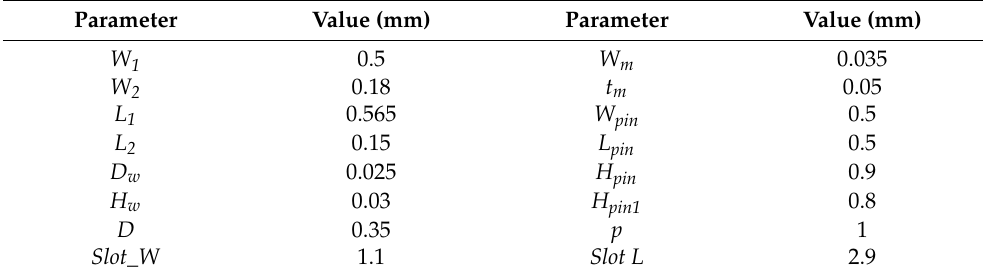
Figure 10. Effect of the bond wire length on the designed transition frequency response. Table 2. Optimum dimension parameters for the MMIC-to-waveguide transition, based on a glide- symmetric holey EBG, at the E